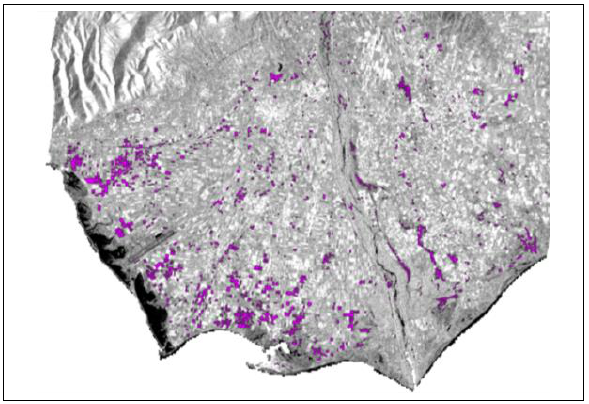
Figure 2. The available information of Copernicus Emergency Management Service (© 2015 European Union), [EMSR292] Chrisoupoli: Delineation Map (in magenta) on Sentinel-1 image